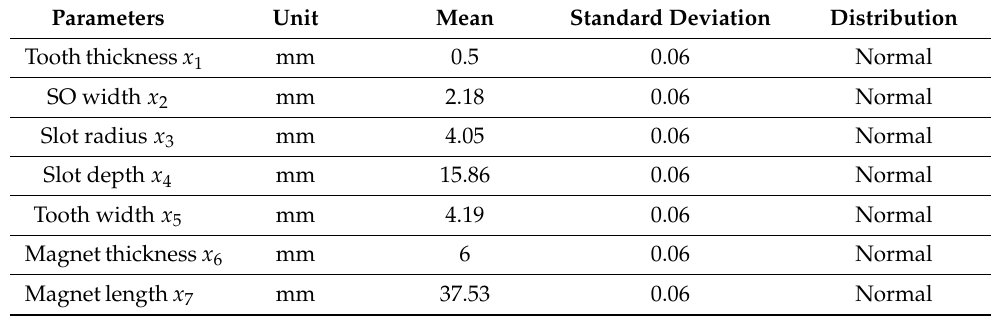
Table 3. Probabilistic distribution of the design variables of the BLDC motor.